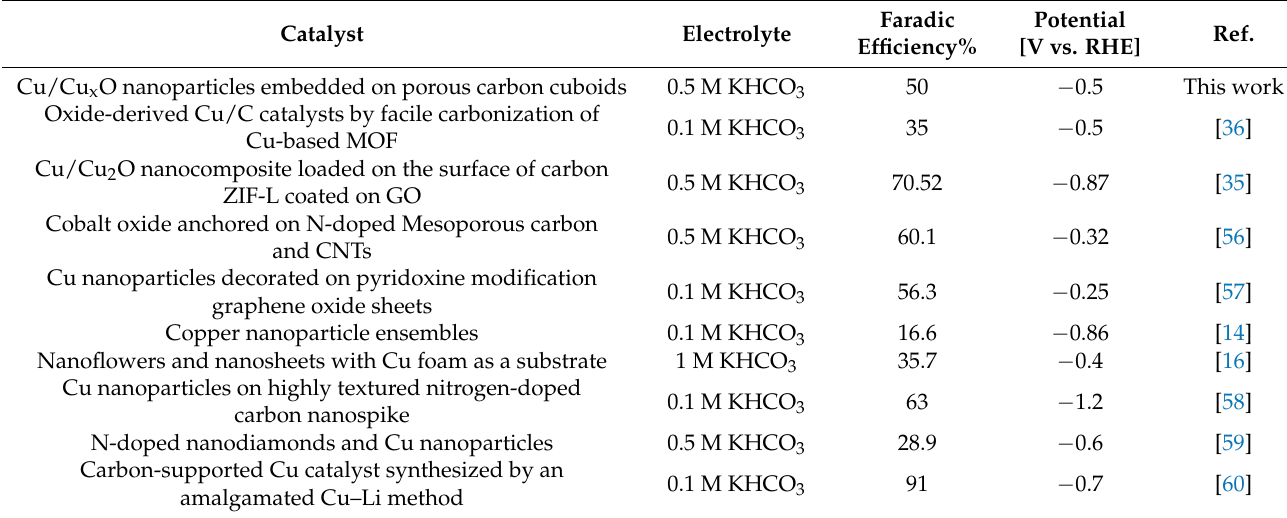
Table 2. Comparison of CO 2 reduction to ethanol with different types of electrocatalysts from the literature. Catalyst Electrolyte